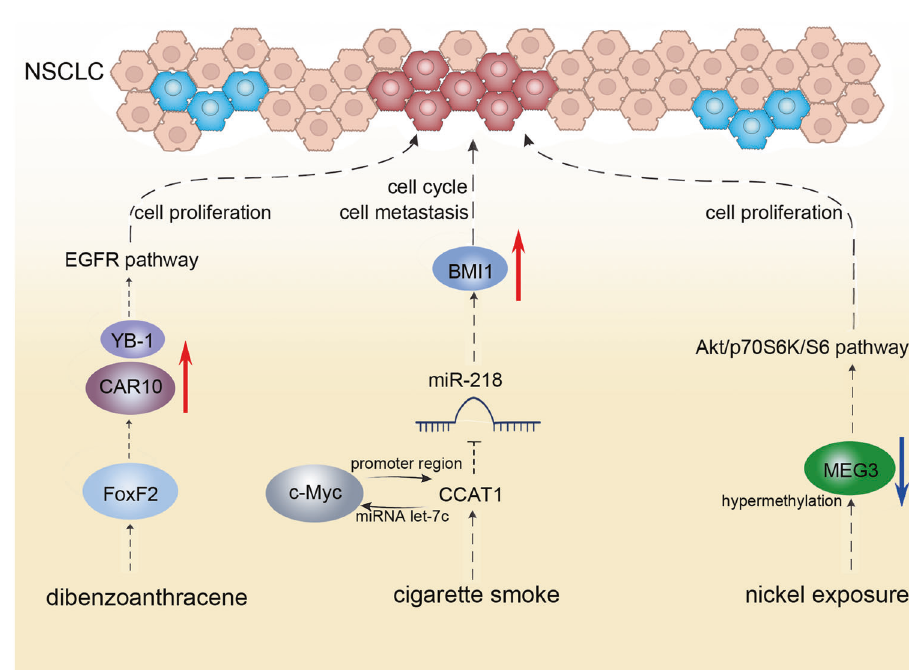
Fig. 1 Schematic of LncRNA-based regimen in